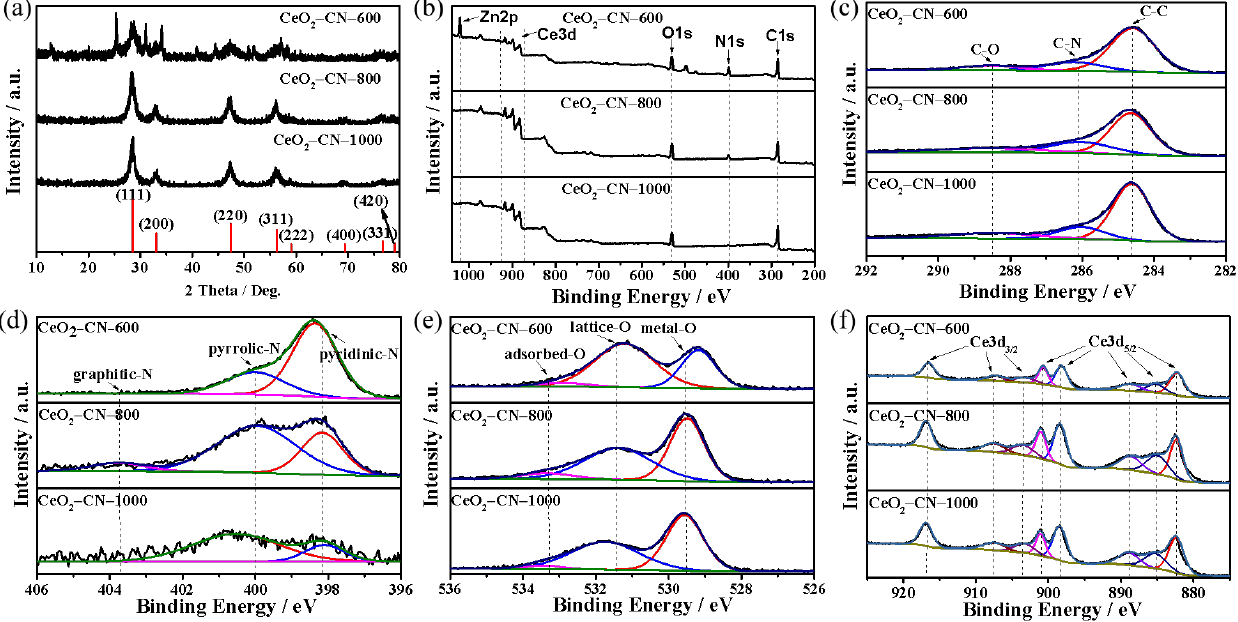
Figure 2. ( a ) XRD patterns of CeO 2 – CN calcined at 600 ℃ , 800 ℃ , 1000 ℃ . XPS spectra of CeO 2 – CN calcined at 600 ℃ , 800 ℃ , 1000 ℃ for ( b ) survey, ( c ) C1s, ( d ) N1s, ( e ) O1s, and ( f ) Ce3d.